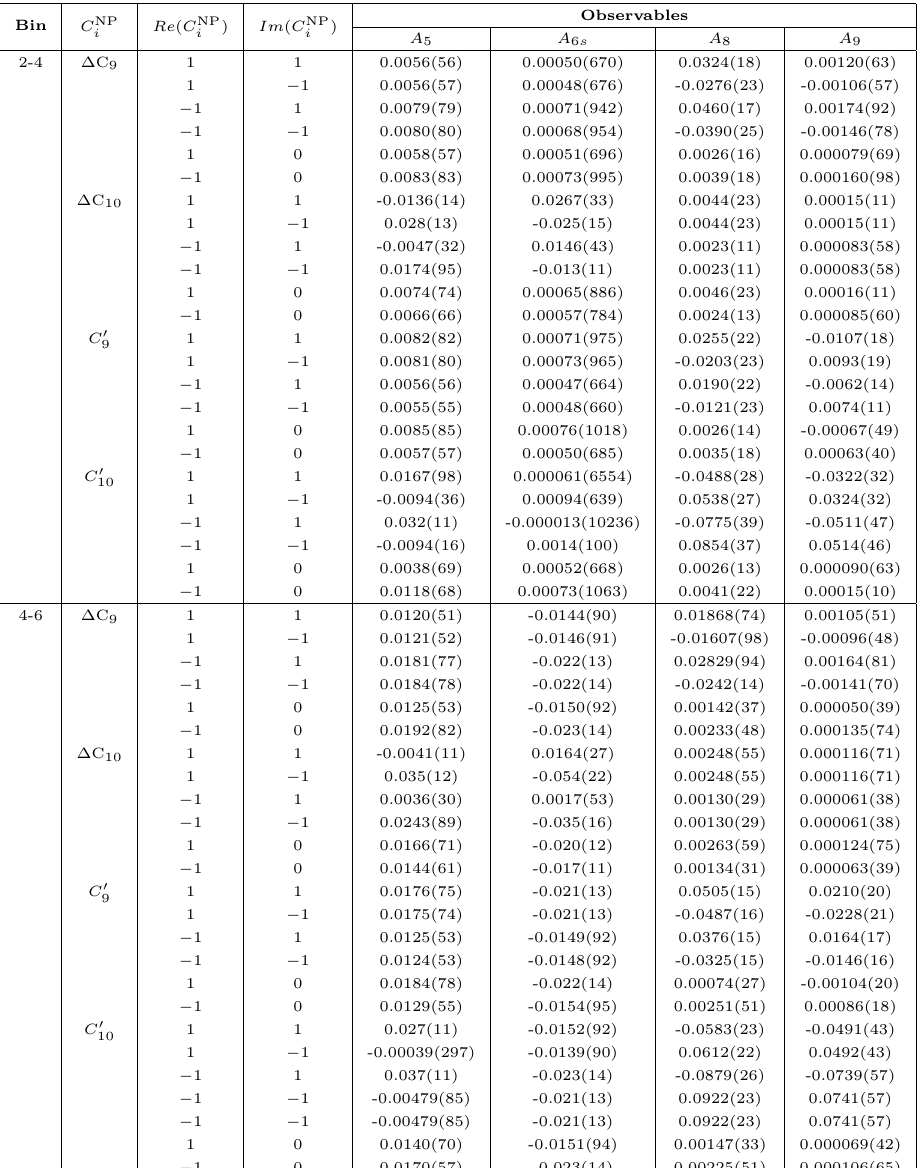
¯ B ( B ) → ρ 0 ll on the and C 0 for the q 2 bins 2 − 4 and 4 − 6 GeV 2 for 9 , 10 9 , 10